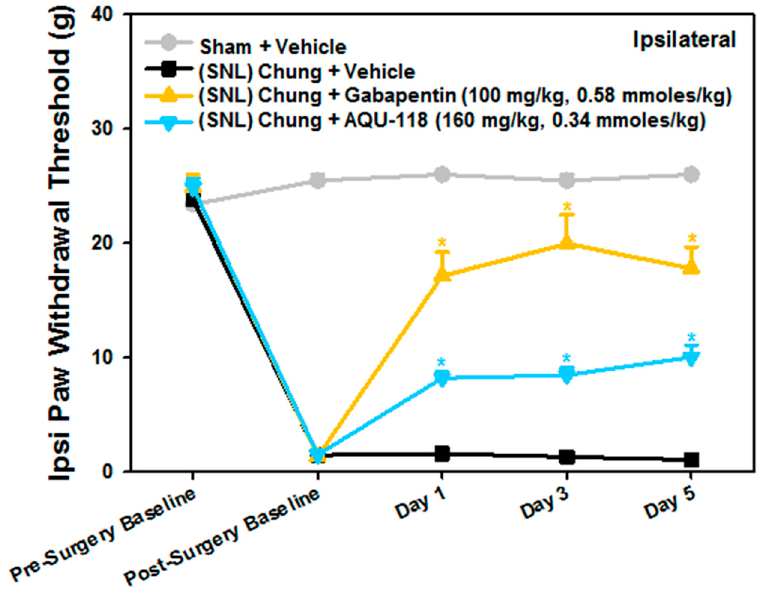
Figure 1. Mechanical Response Threshold: Spinal Nerve Ligation (SNL) Chung Model (Chung), Ipsilateral (Ipsi) Paw Withdrawal. Paw withdrawal thresholds following SNL-surgery for ipsilateral hind paws. Data are presented as mean ± SEM. * p < 0.05 vs. (SNL) Chung + Vehicle group on the same day. Post-Surgery Baseline was performed 15 days after SNL-surgery.